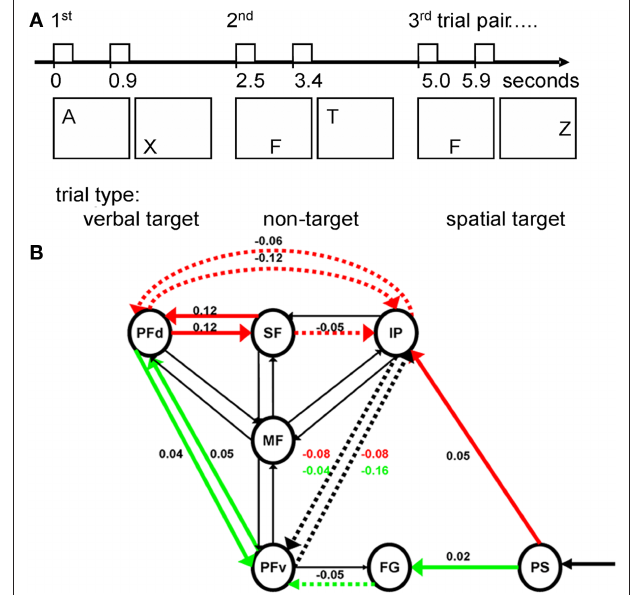
Figure 4 | (A) During a two-modality continuous performance task, subjects monitored a letter stream for successive verbal targets (A then X) or successive spatial targets (3 then 6 o’clock positions). Three correct targets within a modality were rewarded. Reward expectations lead to a graduated bias toward verbal or spatial cognitive sets, according to the recent history of spatial versus verbal targets. (B) The effects of this “top-down” modulation from cognitive set were studied using dynamic causal modeling of fMRI data. The figure shows modulatory (bilinear) effects representing psycho– physiological interactions in the most likely causal model (selected by Bayesian model comparison). This model included the medial frontal (MF) cortex, the dorsal (PFd) and ventral (PFv) lateral prefrontal cortex, the superior frontal sulcus (SF), the intraparietal cortex (IP), the fusiform gyrus (FG), and the prestriate cortex (PS), with intrinsic connections indicated by the presence of arrows (of any color). Values are time constants (Hz) for the modulatory influences of task bias for which the group posterior mean was positive (solid lines) or negative (dashed lines) for verbal bias (thick green), spatial bias (thick red), or both (thick black). These modulatory effects have strong evidence that they are non-zero, confirmed by post hoc t -tests. The “top-down” modulation of task set resulting from higher reward expectations was associated not only with changing connectivity of the lateral prefrontal cortical regions, but also the feed-forward connections from pre-striate cortex. Moreover, the feed-forward connections were enhanced to parietal cortex with spatial task set bias, and to temporal cortex with verbal task set bias. This illustrates that domain specific “top-down” control is not restricted to changes in feedback connections from higher cortical areas, but is also manifest by changes in feed-forward connectivity. From Rowe et al.